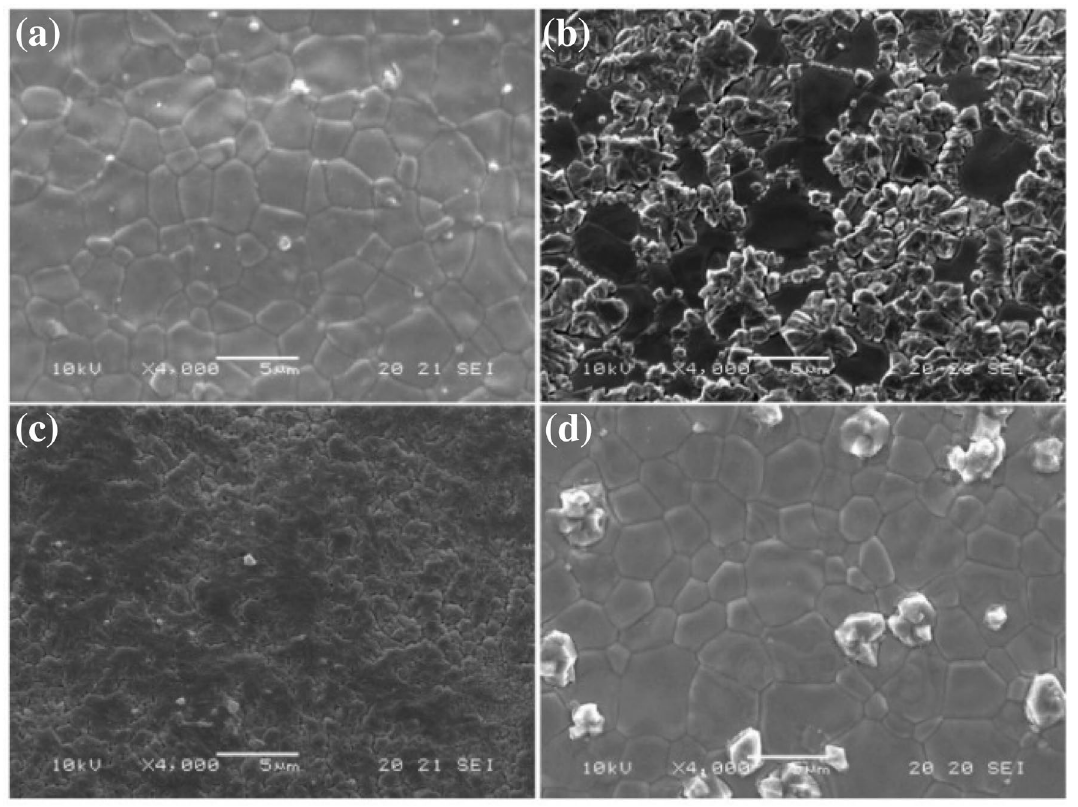
Fig. 8 SEM images of the YSZ surface with the corrosion test in Li-K carbonate at 700 °C for 10 h: a before the corrosion test; b in air; c in Ar; d in 5% H 2 /Ar. Reproduced from ref.